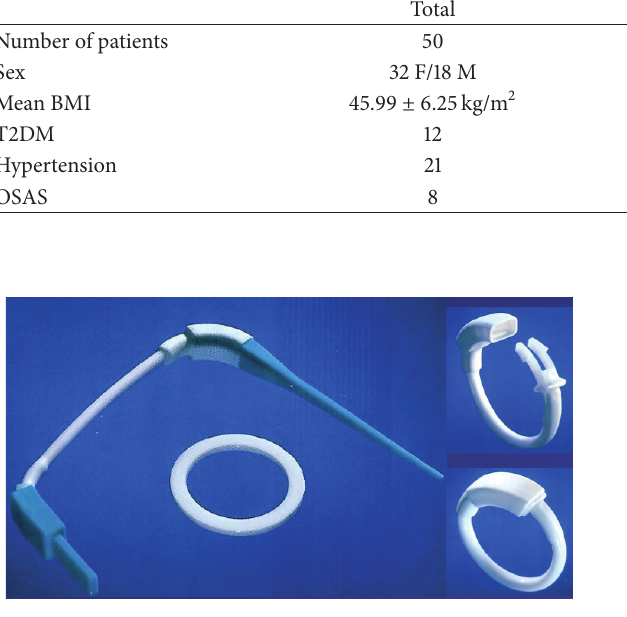
Figure 3: GaBP Ring Autolock System.